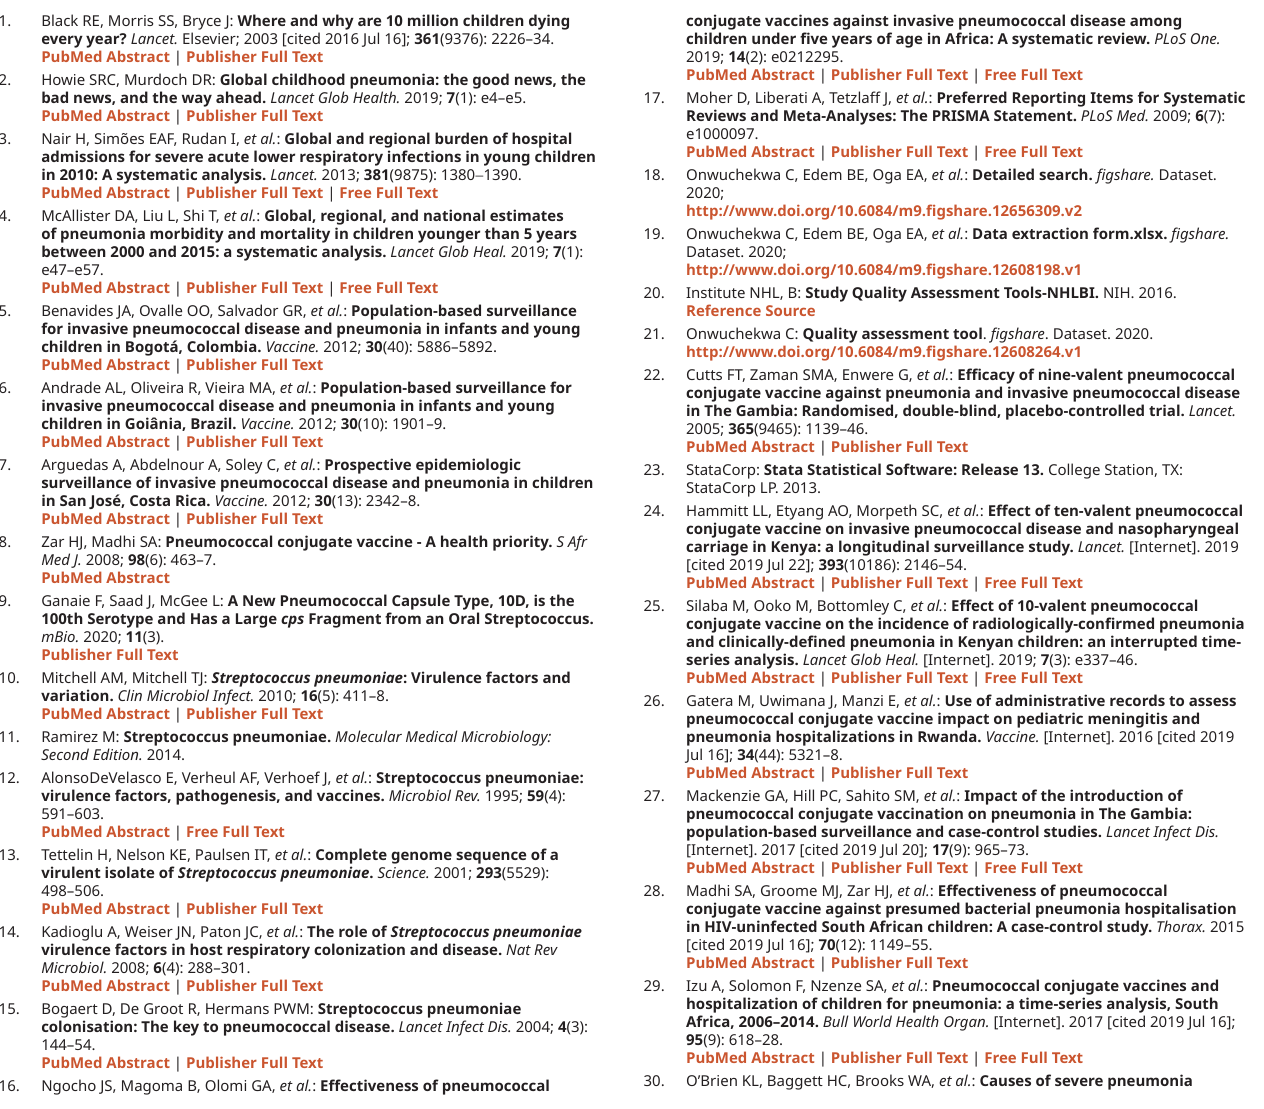
Figshare: Data extraction form https://doi.org/10.6084/m9.figshare. Figshare: Quality assessment tool https://doi.org/10.6084/m9.figshare. 12608264